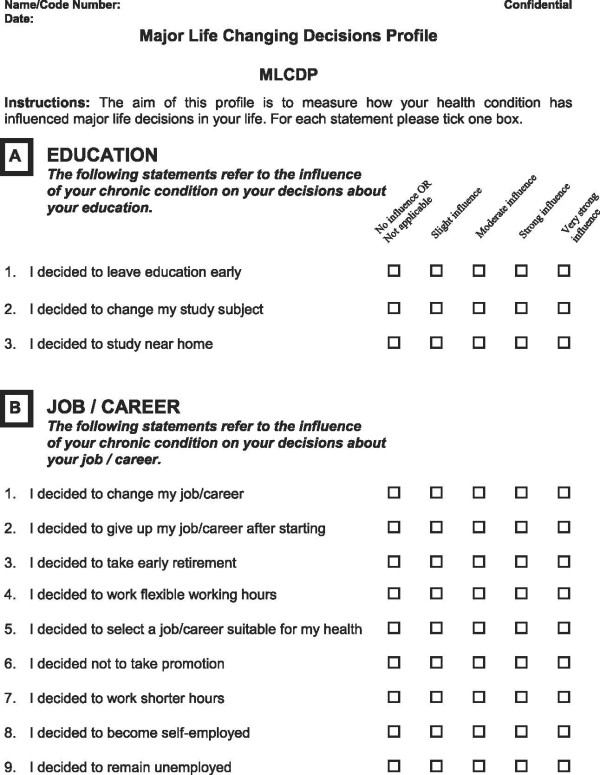
The 32-items MLCDP Part 1.